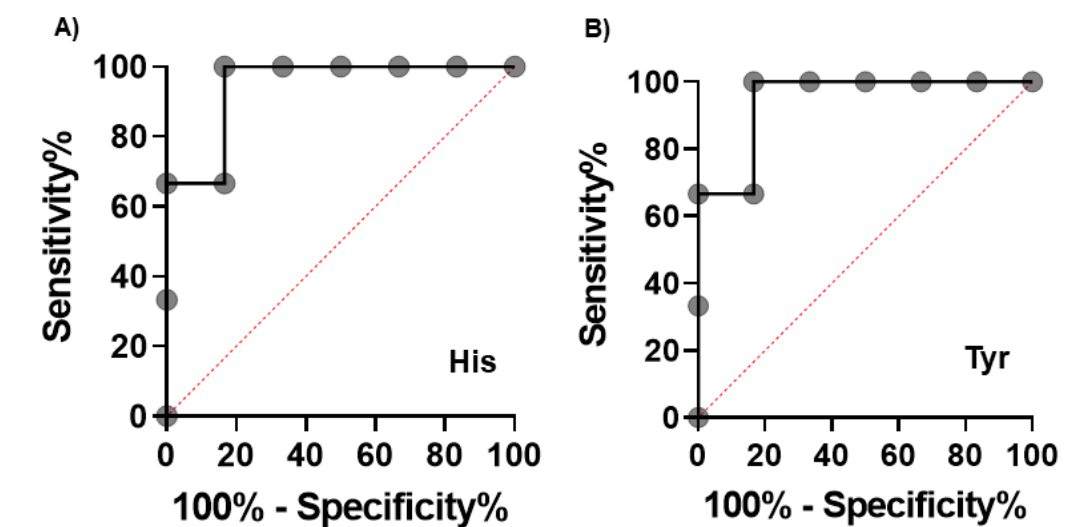
Figure 3. ROC curves to discriminate higher grade group ( n = 3) from lower grade group ( n = 6) based on the saliva collected before radiation therapy. The X and Y axes indicate the 100-specificity (%) and sensitivity (%), respectively. ( A ) His and ( B ) Tyr. The larger area under the curves indicates higher sensitivity of accuracy to discriminate. The AUC values were 0.94 (95% confidence interval (CI): 0.79 − 1.0, p = 0.039) for both metabolites.